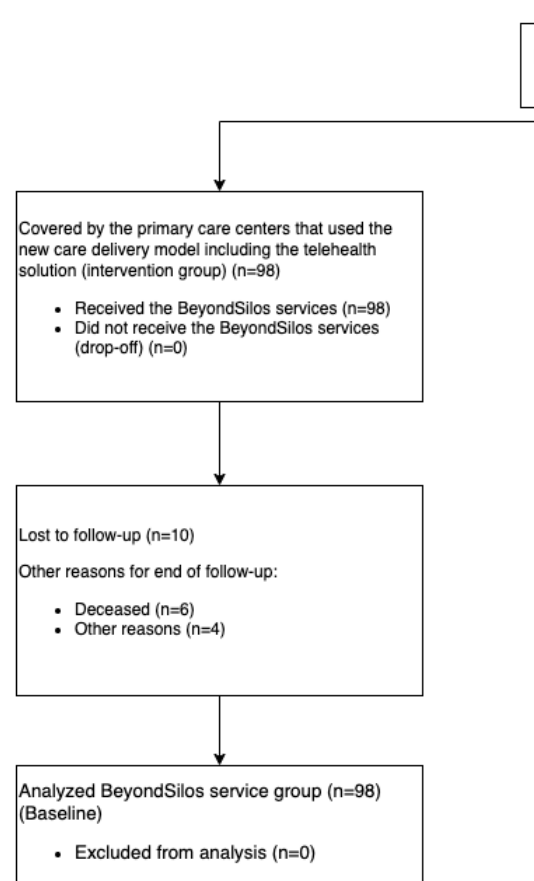
the intervention group tended to be overrepresented by older, female, and widowed